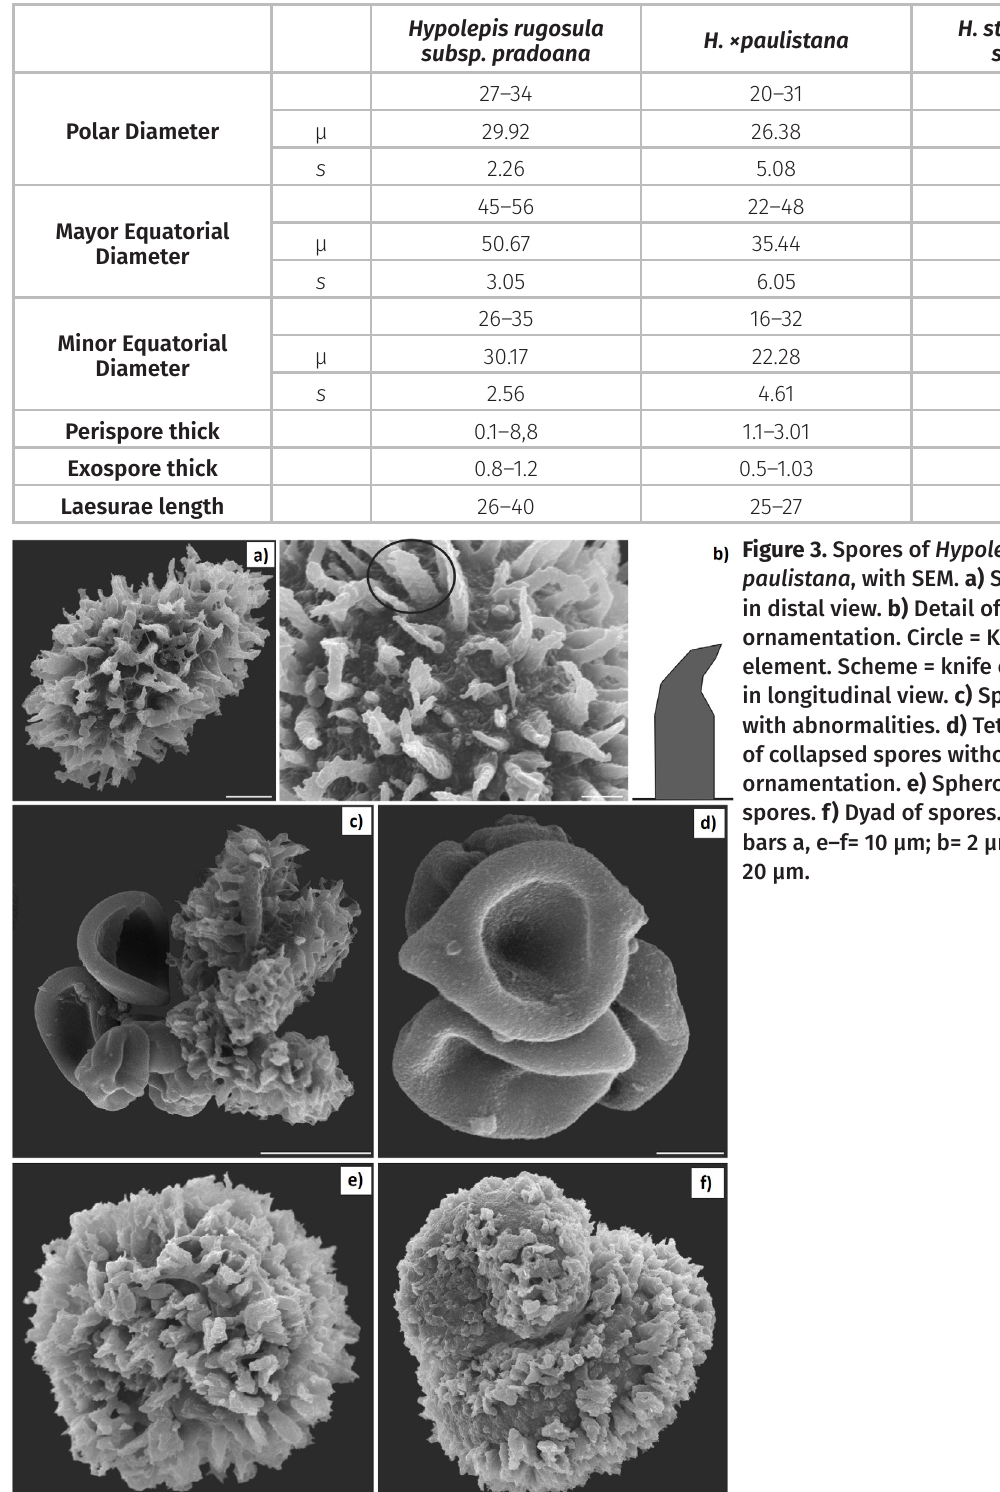
Figure 3. Spores of Hypolepis x paulistana , with SEM. a) Spore in distal view. b) Detail of ornamentation. Circle = Knife element. Scheme = knife element in longitudinal view. c) Spores with abnormalities. d) Tetrads of collapsed spores without ornamentation. e) Spheroidal spores. f) Dyad of spores.